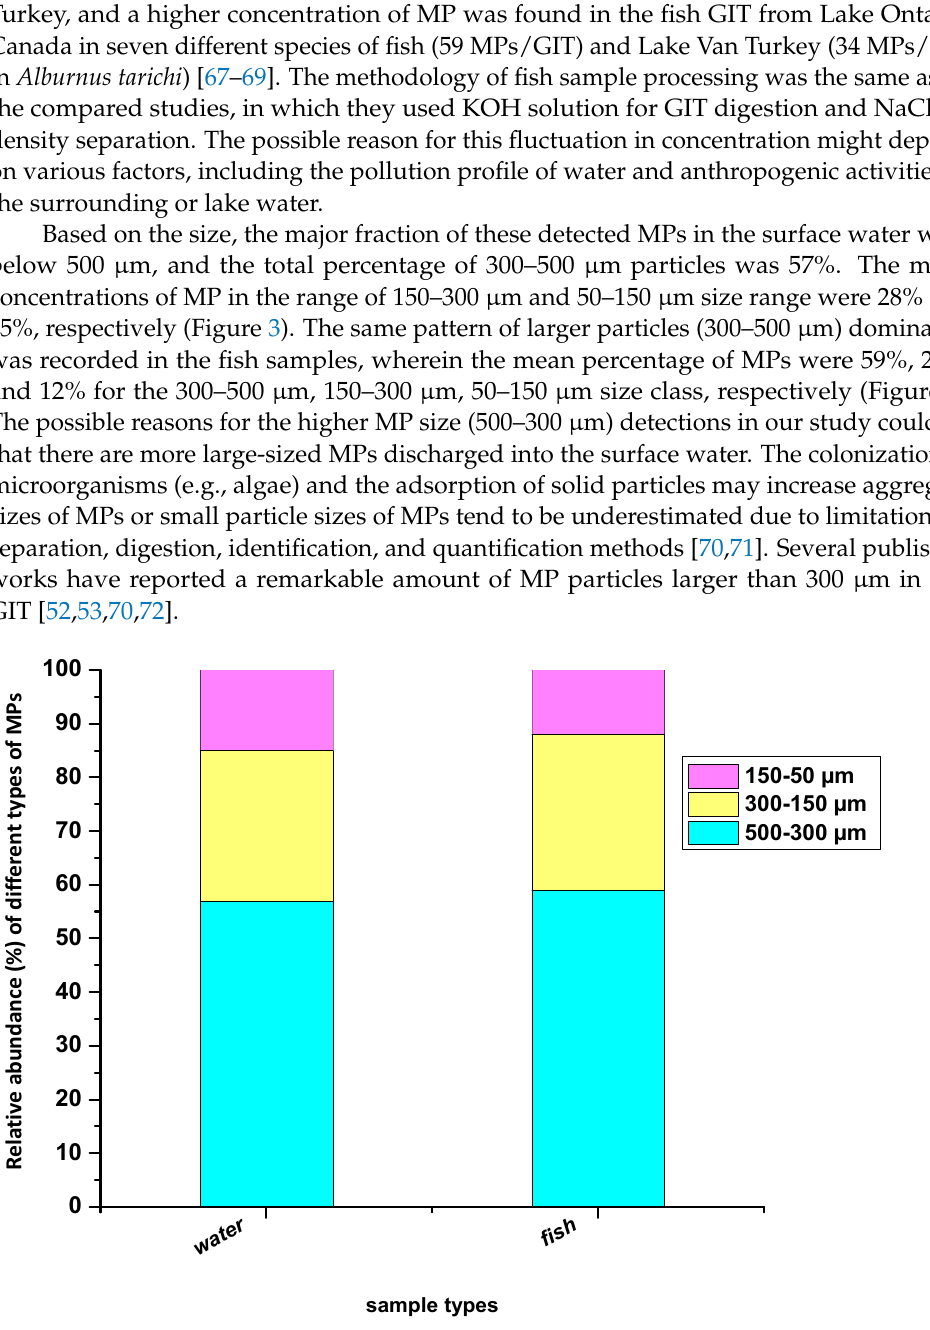
Figure 3. Relative abundance of identified MPs of three size classes that recovered from the surface water and fish GIT samples.